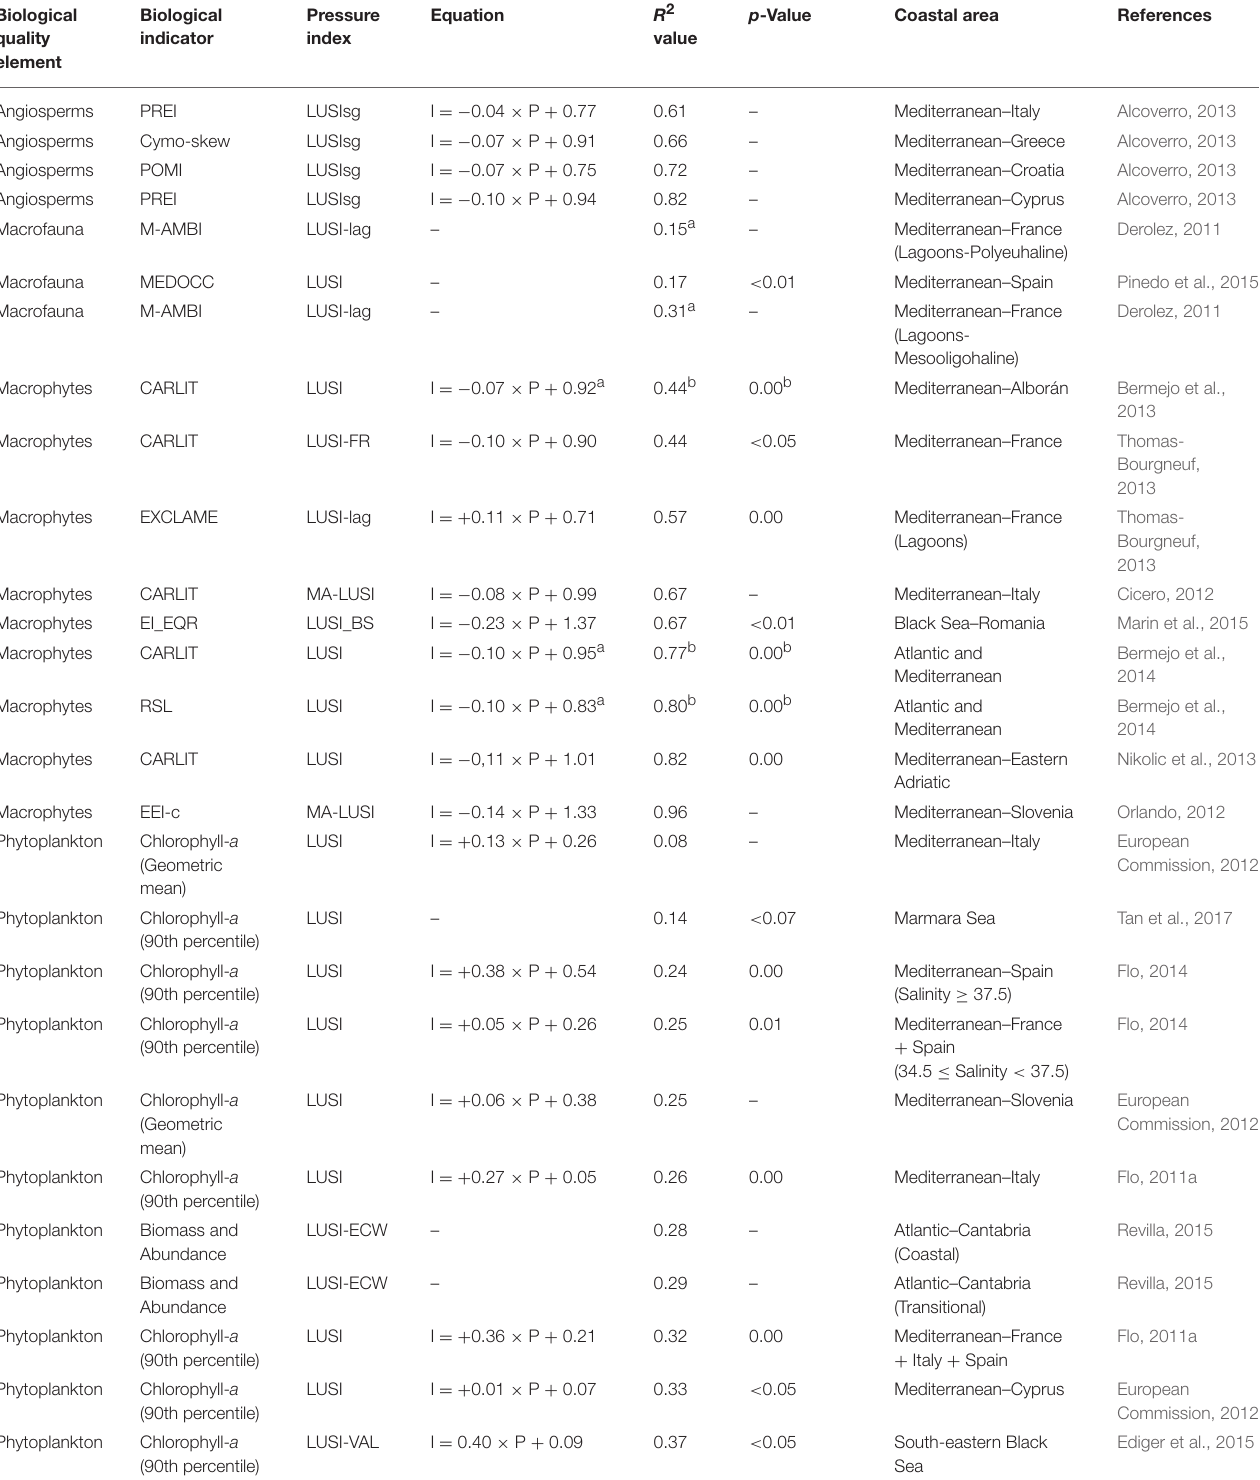
TABLE 6 | Pressure-impact relationships between LUSI, as pressure (P), and biological indicators related to the Biological Quality Elements of the Water Framework Directive for coastal waters, as impact (I). Biological